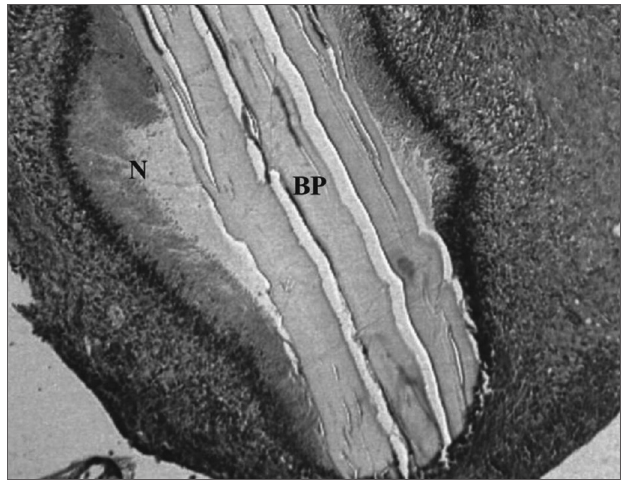
Figure 5. Experimental group with 4 weeks - Microphotography of the subacute exudate of moderate degree around the sugar cane biopolymer membrane; BP= sugar cane biopolymer. N= cell necrosis. HE (100x magnification)